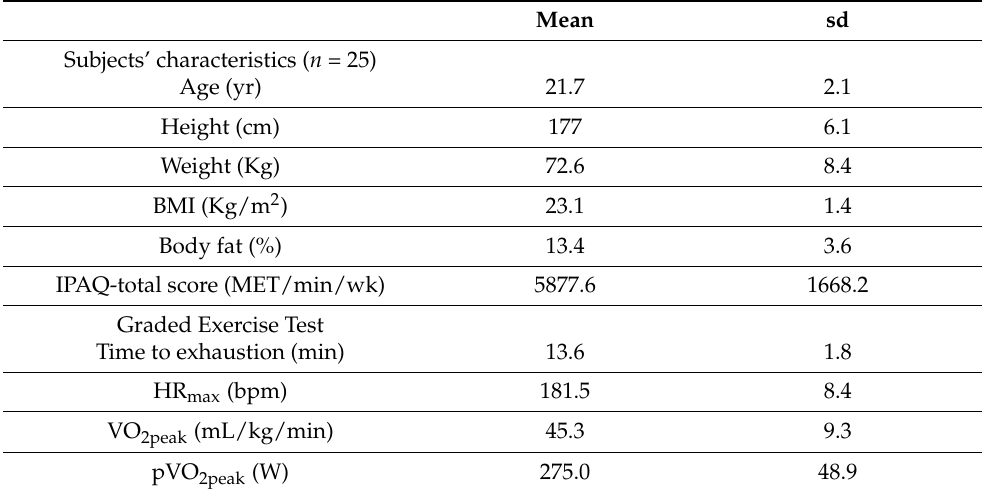
Table 1. General characteristics of subjects and results from the graded exercise test (session